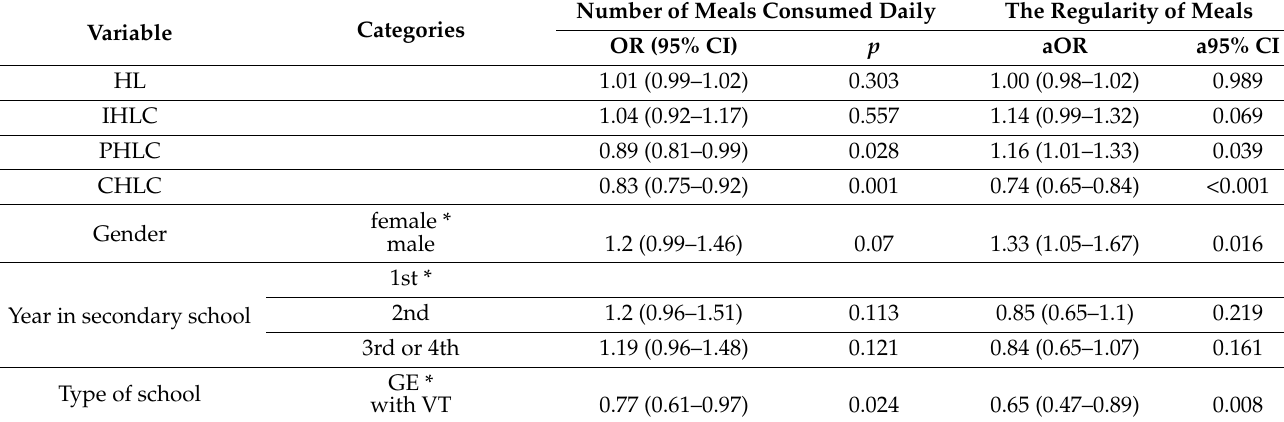
Table 2. Multivariate logistic regression models for the number of meals consumed daily and the regularity of meals.